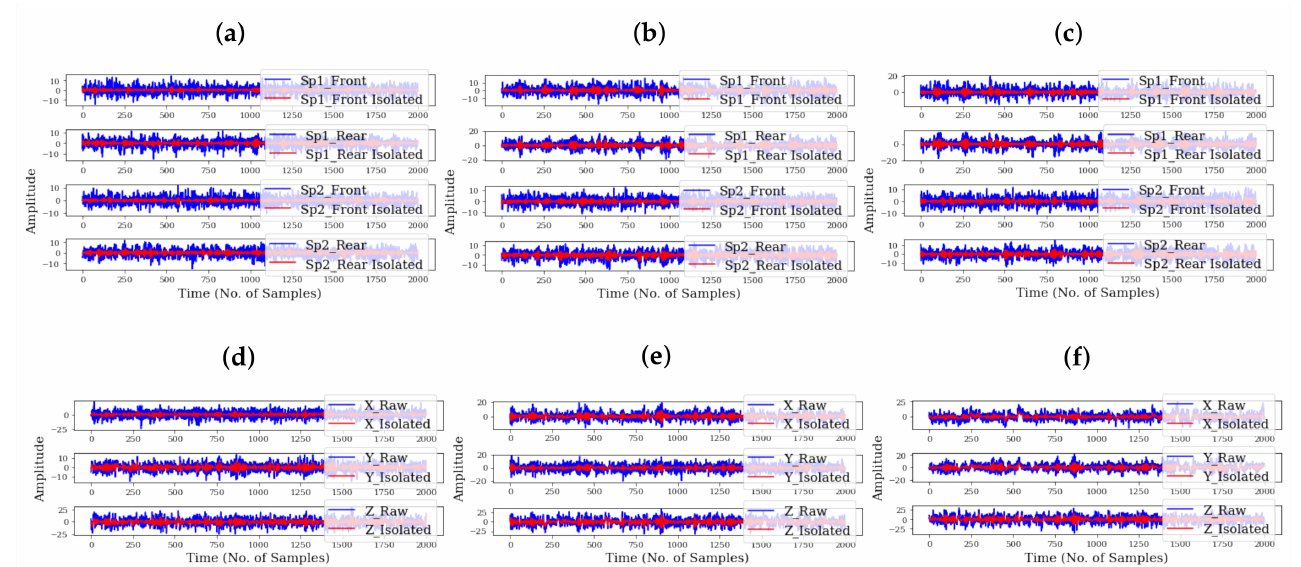
Figure 8. Raw vibration signals (in blue) and their corresponding spectral isolation outputs (in red) for ( a ) spindle at healthy/normal state, ( b ) spindle at fairly used state, ( c ) spindle at faulty state, ( d ) frame at healthy/normal state, ( e ) frame at fairly used state, and ( f ) frame at faulty